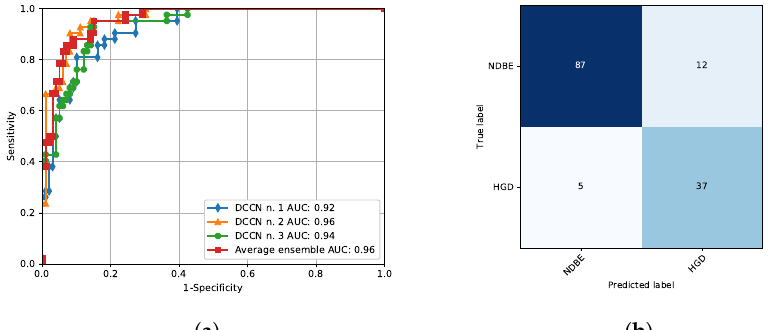
Figure 4. ( a ) Receiver operating characteristic curve for the three trained networks and the resulting ensemble validated on the external dataset. AUC denotes the area under the receiver operating characteristic curve. ( b ) Resulting confusion matrix for the external dataset. Table 3. Evaluation of literature studies using volumetric laser endomicroscopy for detection of neoplasia in Barrett’s esophagus patients. Study Type Analysis Number of Patients Evaluation Method AUC Swager et al. [14] Ex-vivo Single-frame resection 29, endoscopic resections